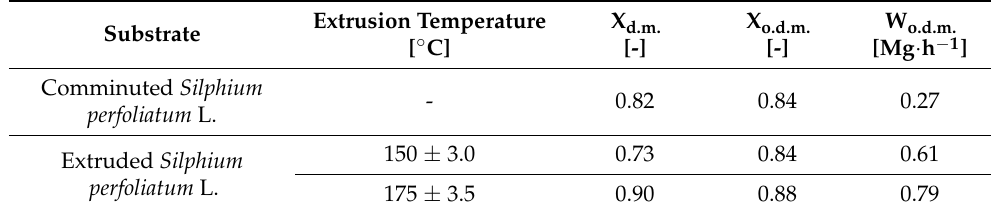
Table 4. The output of the MB11C impact mill and the E-1000 extruder in relation to the organic dry matter of the substrates.